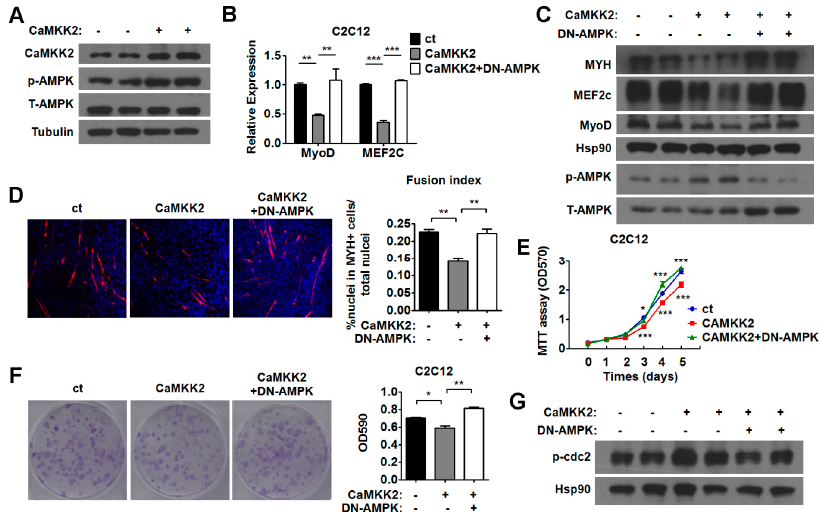
transfected with siCaMKK2 (Figure S5F–I). Together, these results further supported the notion that AMPK mediates the effect of CaMKK2 on myoblast proliferation and differentiation.